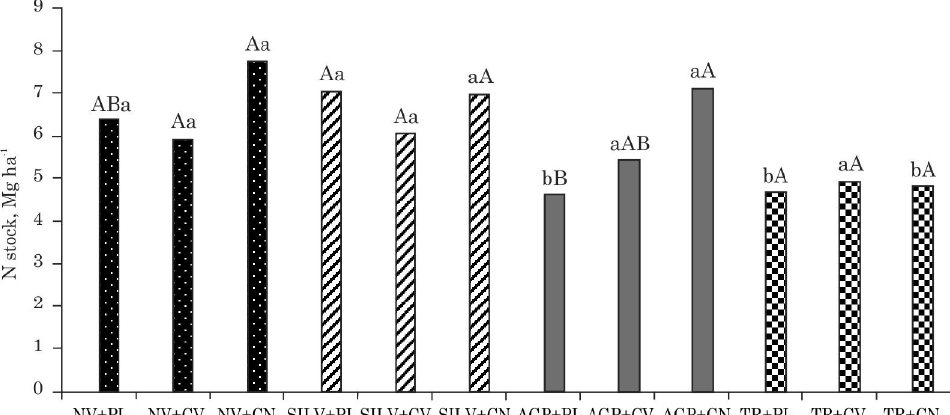
Figure 7. Soil total N (NT) stocks in the 0-60-cm layer of a typical Ortic Chromic Luvisol under natural vegetation (NV) and silvopastoral (SILV), agrosilvopastoral (AGP) and traditional agricultural (TR) systems under plain (PL), convex (CV) and concave (CN) landforms after 13 years of cultivation in Luvisol in Sobral-CE. Means followed by similar letters do not differ by Tukey’s test at 5 %; uppercase letters compare the landforms in each area and lowercase letters compare the areas in each